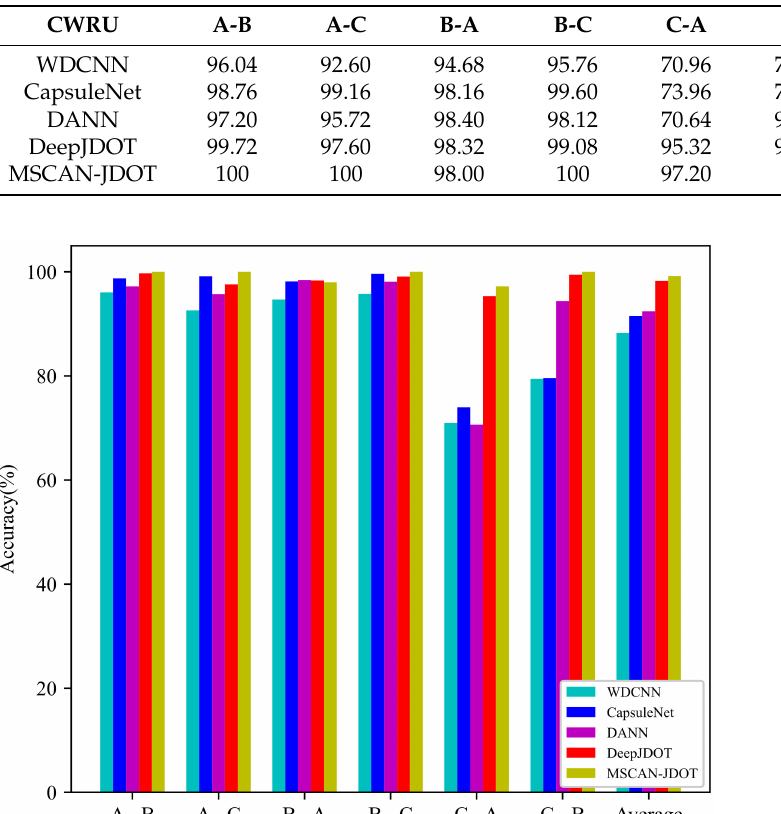
Figure 7. Visualization of transfer results on CWRU